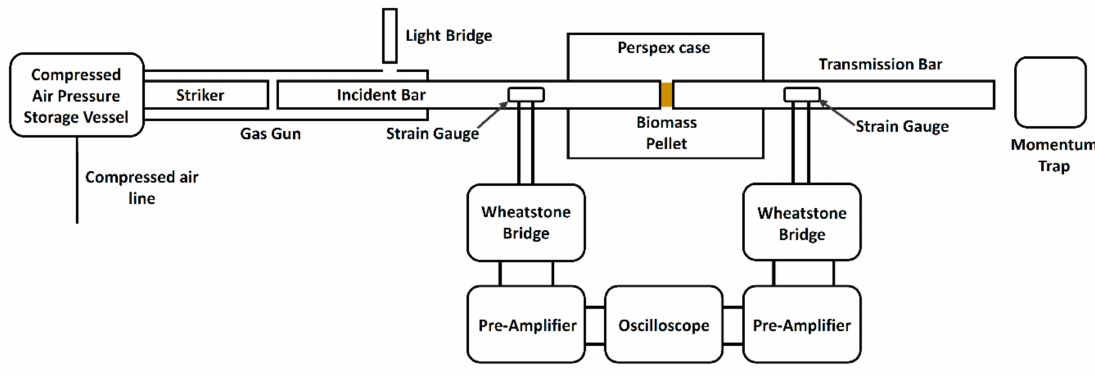
Figure 2. Split Hopkinson pressure bar (SHPB) schematic